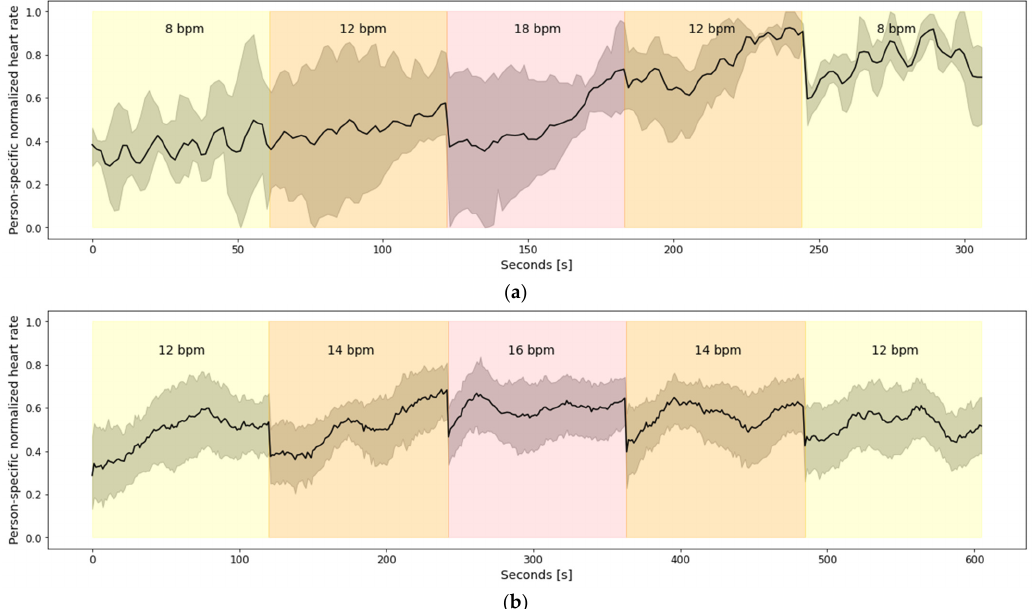
Figure 5. Aggregated heart rate for: ( a ) 3 subjects in Dataset 2.a; ( b ) 10 subjects from Dataset